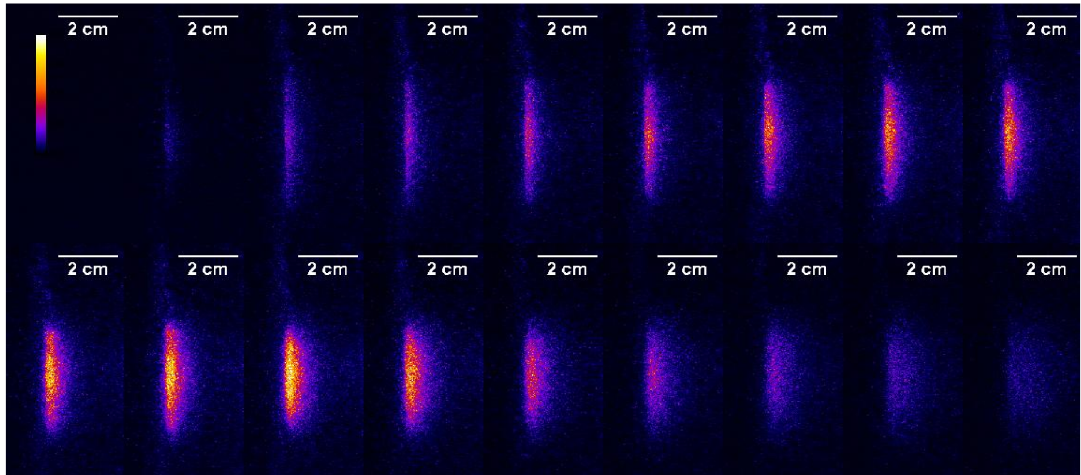
FIG. 6. (Color) Images of the gas cloud taken at 0 : 5 (cid:1) s delay